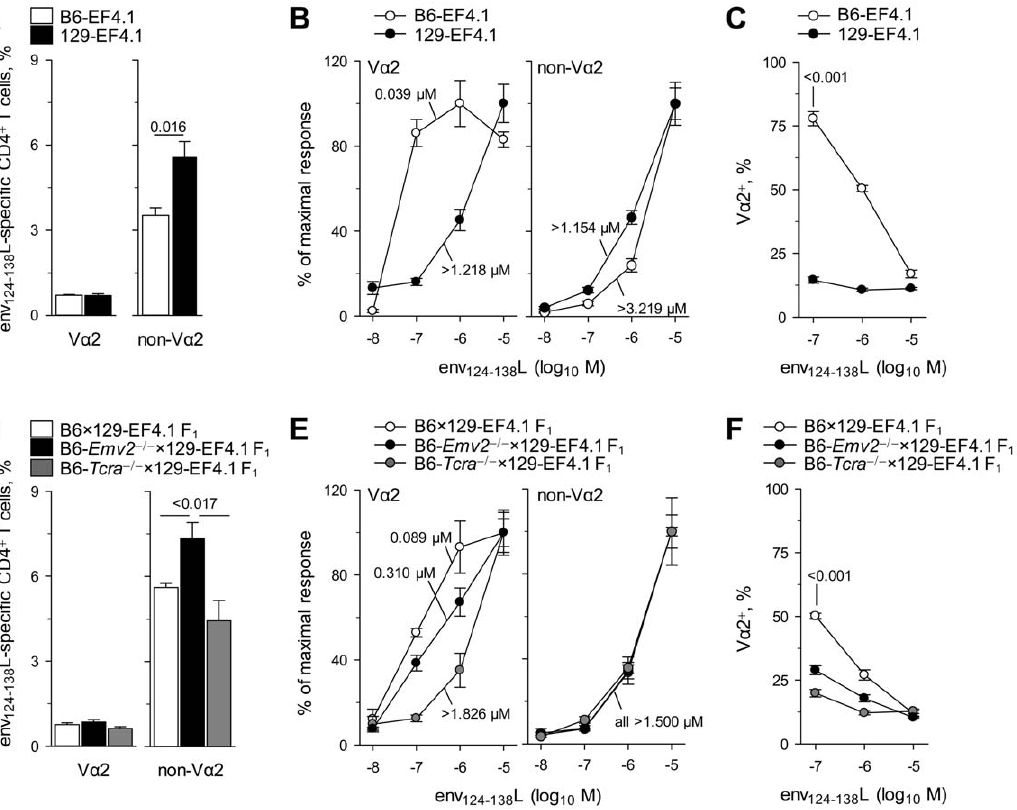
Figure 8. Genetic contribution to a high-avidity env-reactive CD4 + T cell repertoire. (A) Frequency of env 124-138 L- reactive cells in V a 2 or non-V a 2 primary CD4 + T cells isolated from either B6 (B6-EF4.1) or 129S8 (129S8-EF4.1) EF4.1 mice. (B) Functional avidity of env 124-138 L-reactive V a 2 or non-V a 2 primary CD4 + T cells from the same donors in A. (C) Frequency of V a 2 cells in env 124-138 L-reactive CD4 + T cells from the same donors in A as a function of peptide concentration. (D) Frequency of env 124-138 L- reactive cells in V a 2 or non-V a 2 primary CD4 + T cells isolated from either B6 6 129S8-EF4.1 F 1 , B6- Emv2 2 / 2 6 129S8-EF4.1 F 1 or B6- Tcra 2 / 2 6 129S8-EF4.1 F 1 , EF4.1 mice. (E) Functional avidity of env 124-138 L-reactive V a 2 or non- V a 2 primary CD4 + T cells from the same donors in D. (F) Frequency of V a 2 cells in env 124-138 L-reactive CD4 + T cells from the same donors in D as a function of peptide concentration. Numbers in (B) and (E) represent the ED 50 . In (C) and (F) the CD4 + T cell response elicited by the last peptide dose (10 2 8 M) was too small to allow accurate measurement of the frequency of Va2 cells and was therefore omitted. Data in (A–F) are the means 6 SEM ( n =4–8) of 18-hr stimulations from 3 experiments.